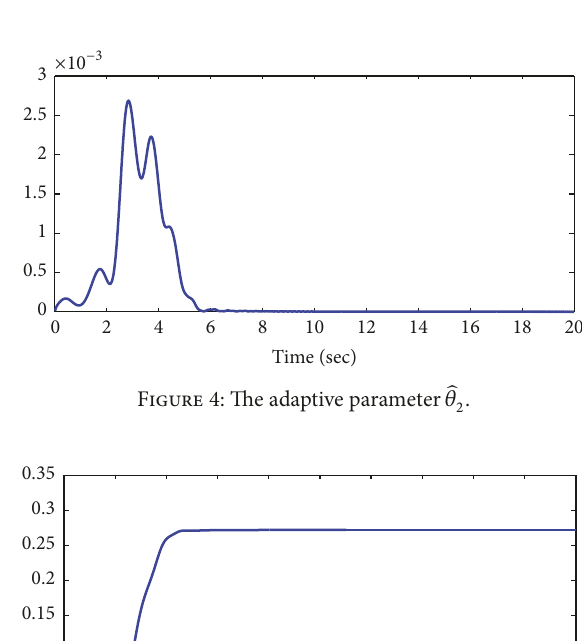
Figure 1: Tracking error 𝑧 1 = 𝑦 − 𝑦 𝑑 .